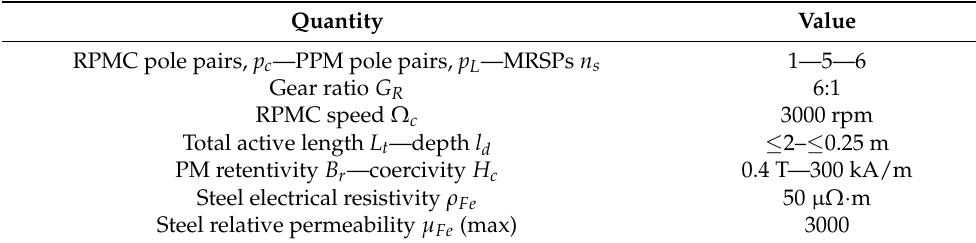
Table 2. RLMC data.